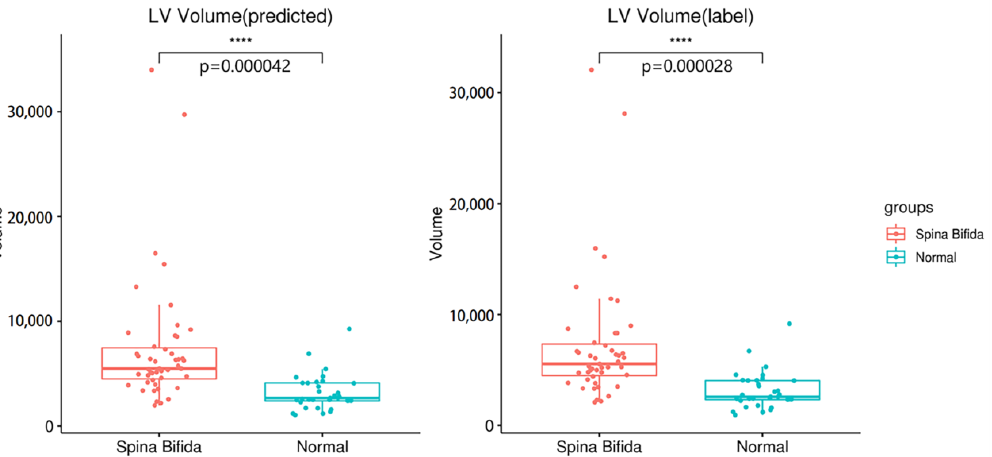
Figure 6. Analysis of ventricular volumes in the normal group and pathological group (spina bifida). **** represents p value less than 0.0001.